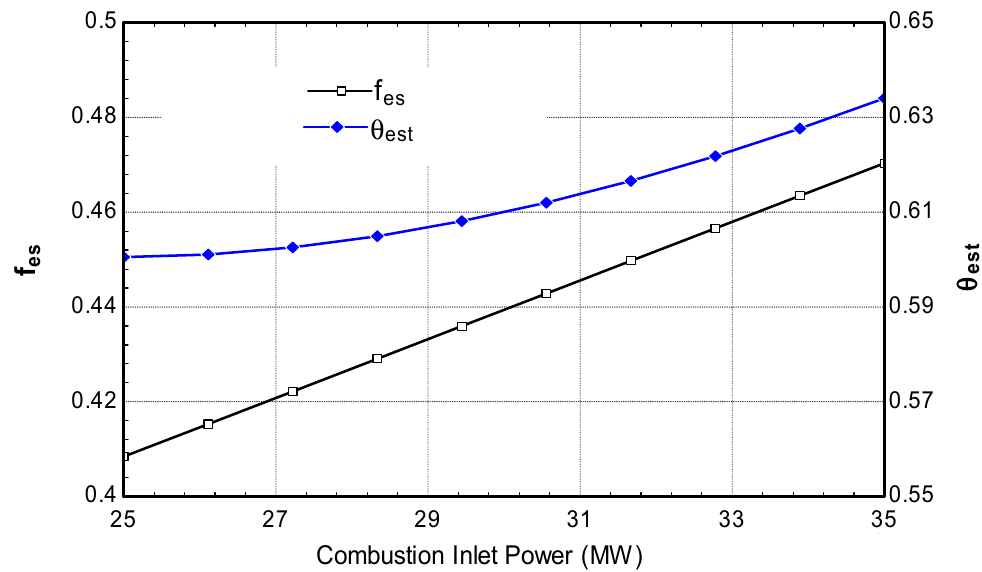
Figure 9. Impact of varying the combustion inlet energy rate on the exergy stability factor and exergetic sustainability index of the overall system.